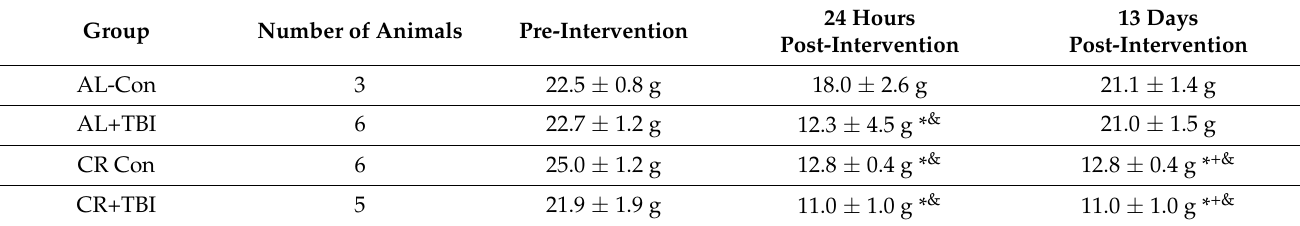
Table 2. TBI and CR significantly decreased food consumption 24 h